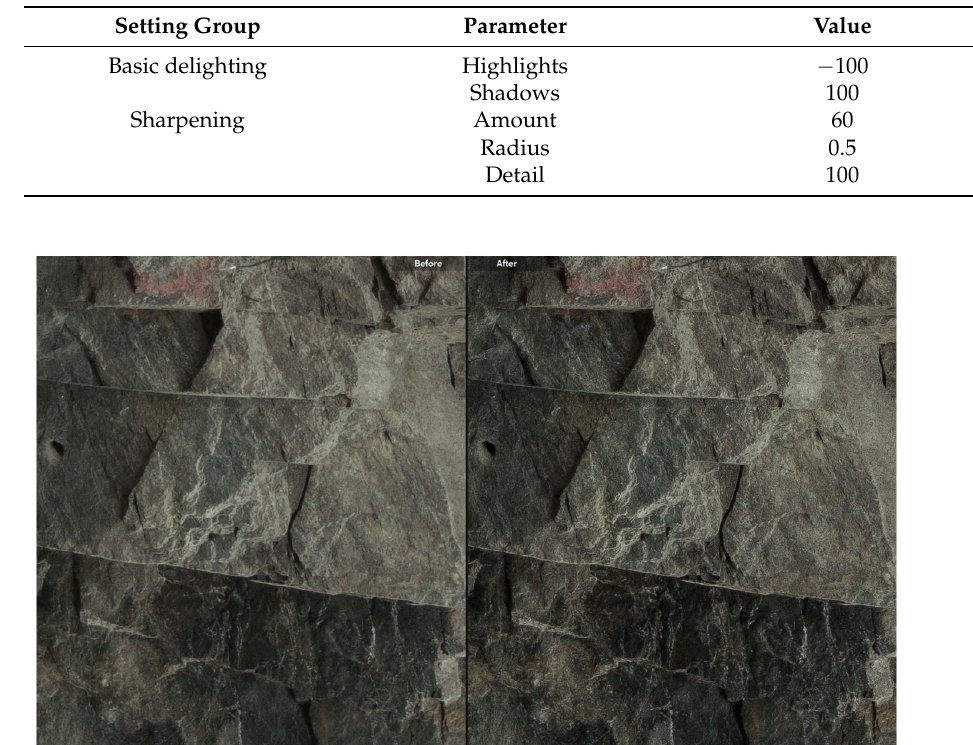
Figure 5. Comparison of the raw ( left ) and processed ( right ) image that was delighted and sharpened in Adobe Lightroom; detailed settings used are given in Table 1.